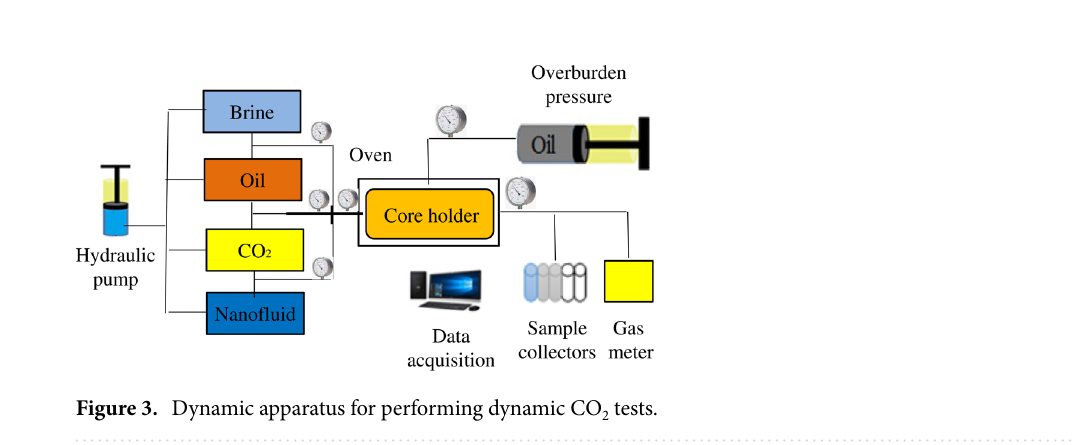
Figure 2. Set up for performing natural depletion.